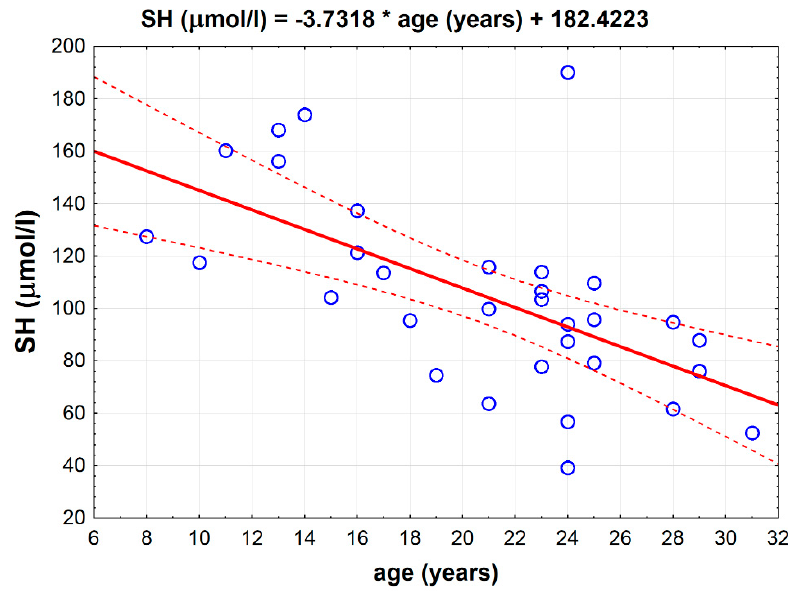
Figure 2. Inverse correlation between total serum thiol -SH concentration and age in all horses ( p < 0.001, r = − 0.6143).